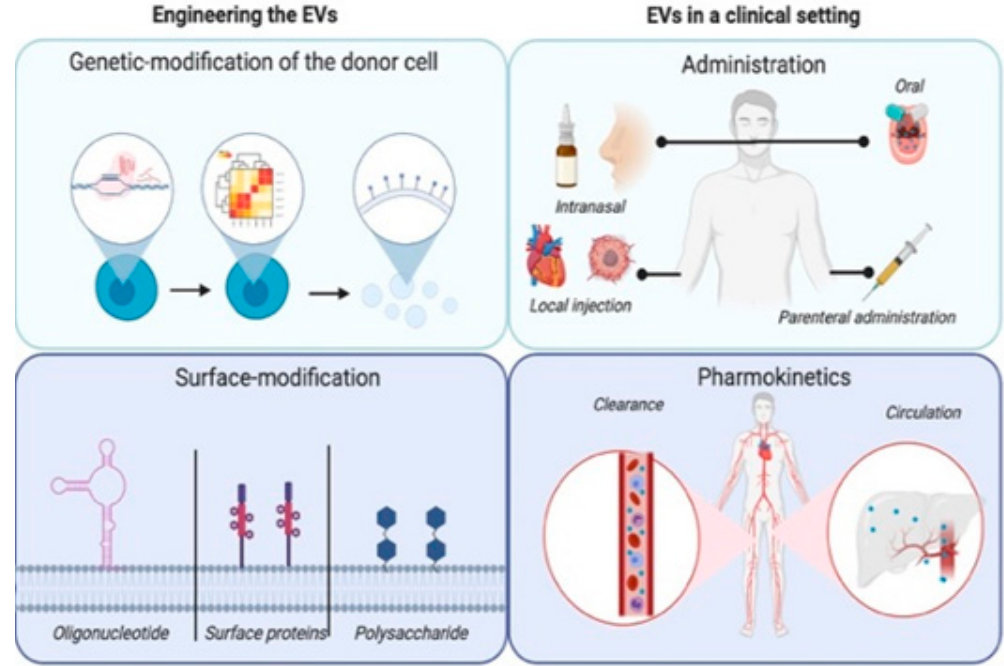
Figure 1. Conceptual overview of the di ff erent phases of EV-based therapy. EVs are produced and can be isolated from a wide range of cell types. EVs could be isolated from tissue biopsies, body fluids, as well as from animal and plant materials. To be used as a DDS, EVs can be isolated, for example, by ultracentrifugation or chromatography, depending on the type of EV and the source. In the second stage, the therapeutic agent will be loaded into the EVs. With pre-loading methods, the agent will be encapsulated into the EV in a natural way (i.e., using the machinery of the cell of origin). Post-loading approaches consist of physical or chemical methods, in which a disruption of the cell membrane of the already purified EV is induced. To improve the e ffi cacy of the therapy, EVs can be modified, for instance, to increase the expression of certain receptors on the membrane, and this way its interaction with specific target cells or to avoid phagocytosis by the mononuclear phagocytic system. Finally, EVs are administered to the patients. The use of a proper route of administration may improve the pharmacokinetics of the drug by avoiding clearance or accumulation in o ff -target